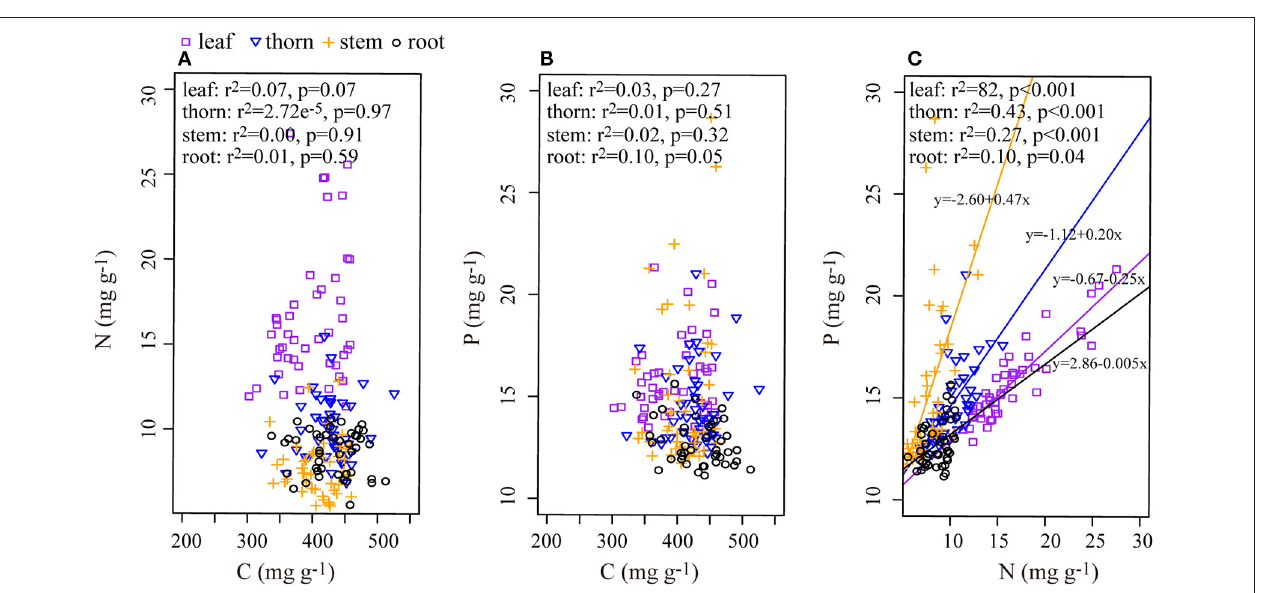
TABLE 2 | Correlations of C:N, C:P, and N:P ratios among the leaf, thorn, stem, and root organs of Alhagi sparsifolia .